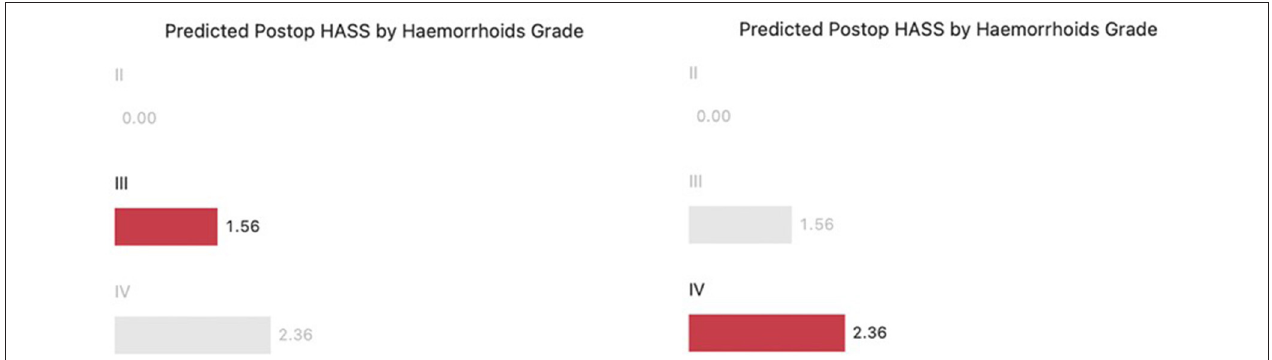
FIGURE 5 | Predicted post-operative HASS by hemorrhoids grade (Kruskal-Wallis, p = 0.163).